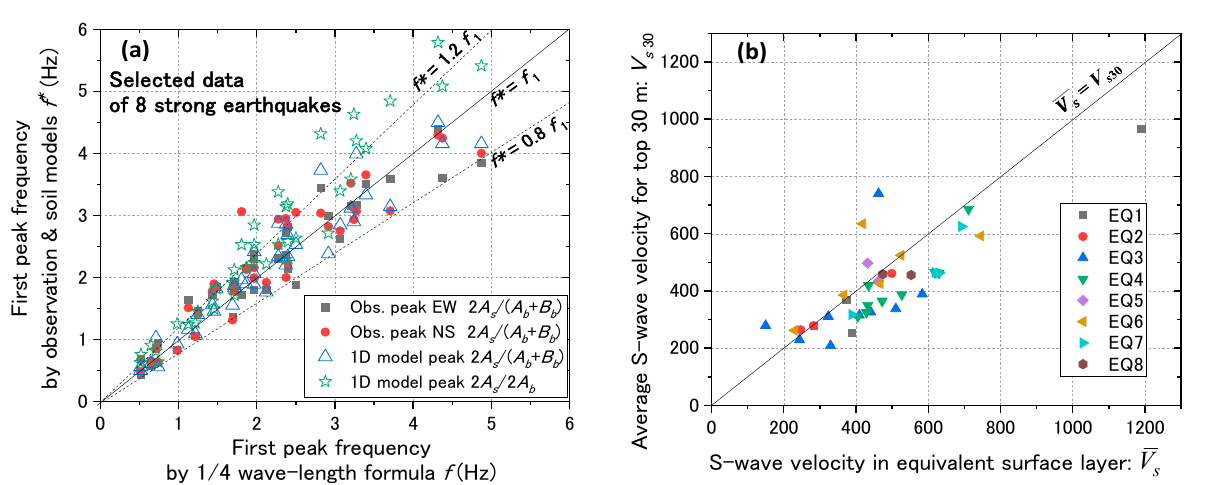
Figure 10. First peak frequencies by 1/4 wavelength formula versus observation ( a ), and S-wave velocities in the equivalent surface layer V s versus in top 30 m V s 30 ( b )